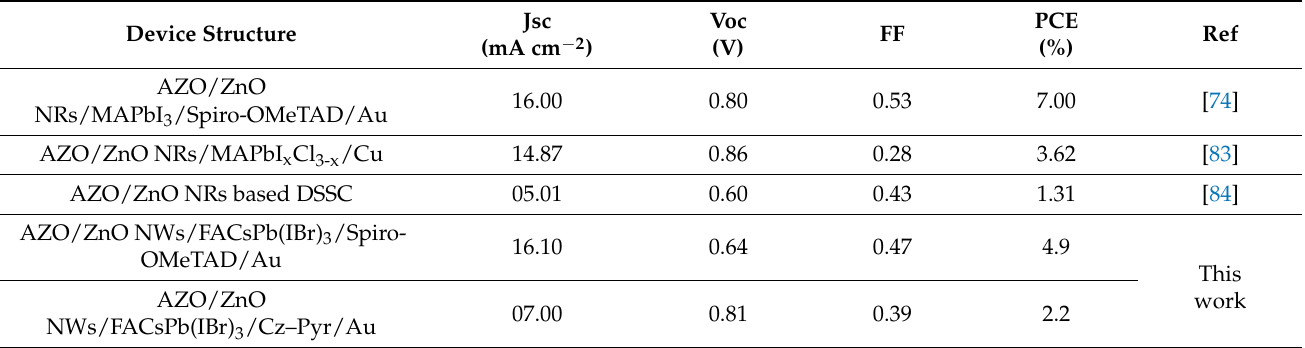
Table 9. Published PV performance of AZO/ZnO NWs/perovskite architecture devices. Device